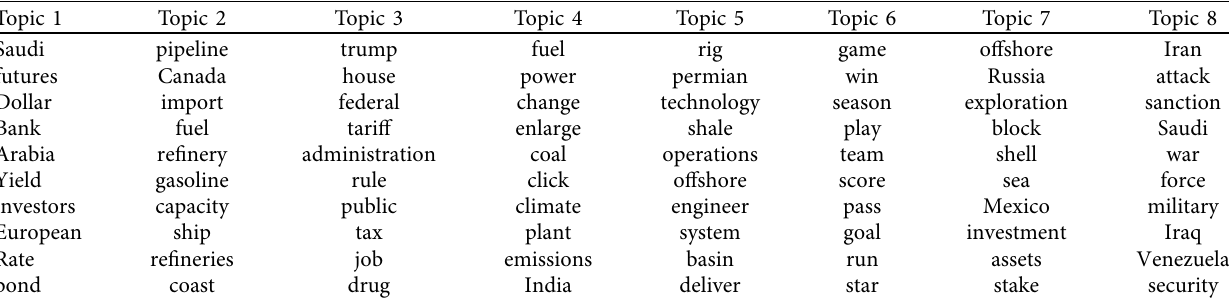
Figure 3: Comparison of Brent oil prices and HD. (a) The trend of Brent oil prices and PHD. (b) The trend of Brent oil prices and Table 3: The keywords of topics related to oil market news.